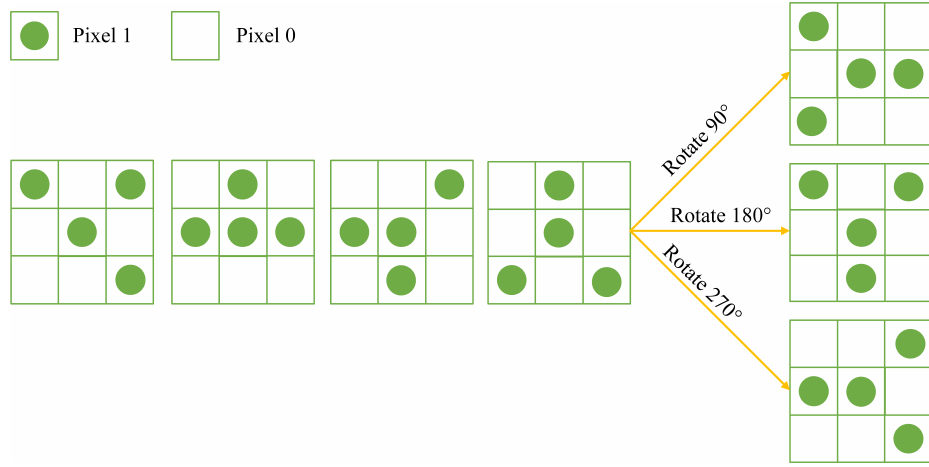
Figure 7. Branch point detection